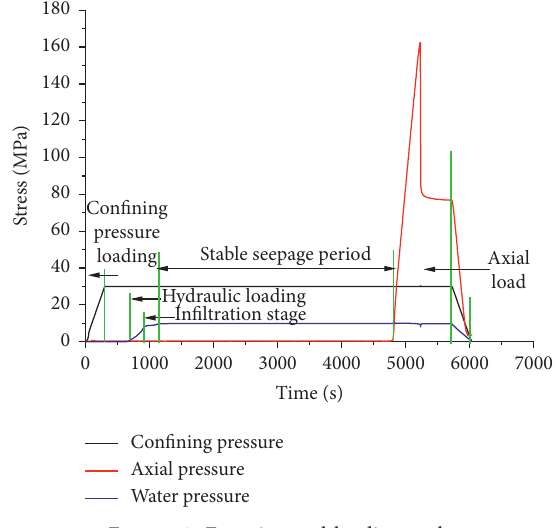
Figure 3: Experimental loading path.